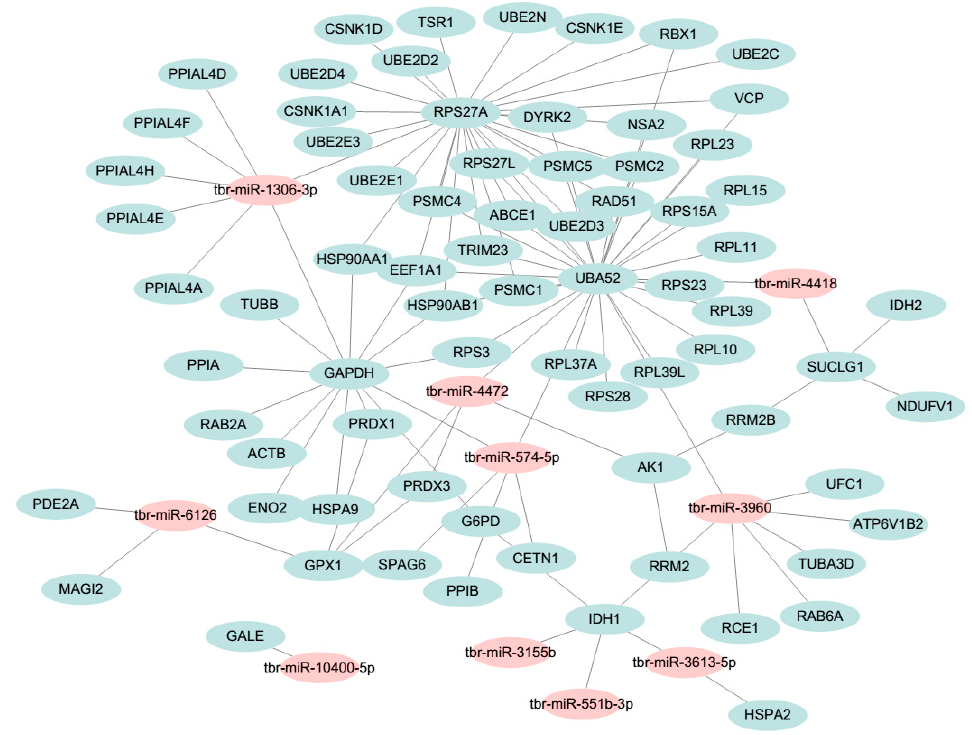
Figure 6. The miRNA–gene interaction sub-network. The pink node represents a miRNA, while the light blue node represents a gene. The full view of this network is shown in the Supplementary Materials.